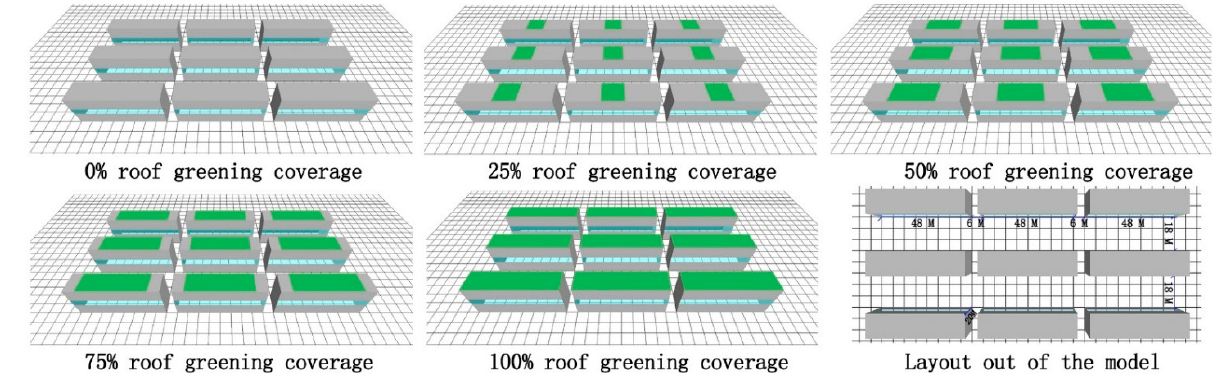
Figure 1. Research models of this study. Table 1. Properties of the mixed substrate in this research.